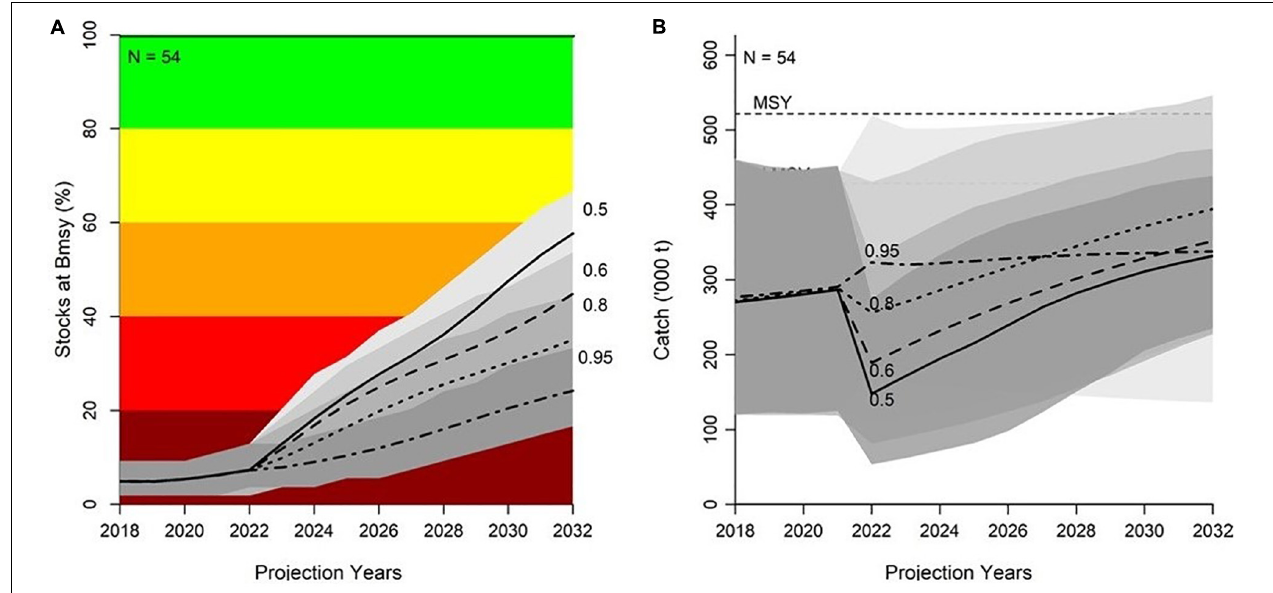
FIGURE 5 | Future scenarios for all of Turkeys’ 54 commercial stocks assessed in this study, showing the (A) predicted percentage of stocks reaching the Bmsy level, and (B) predicted cumulative catch under four different fishing mortality scenarios, ranging from 0.5 to 0.95 Fmsy. Gray areas indicate the approximate 95% CI for each